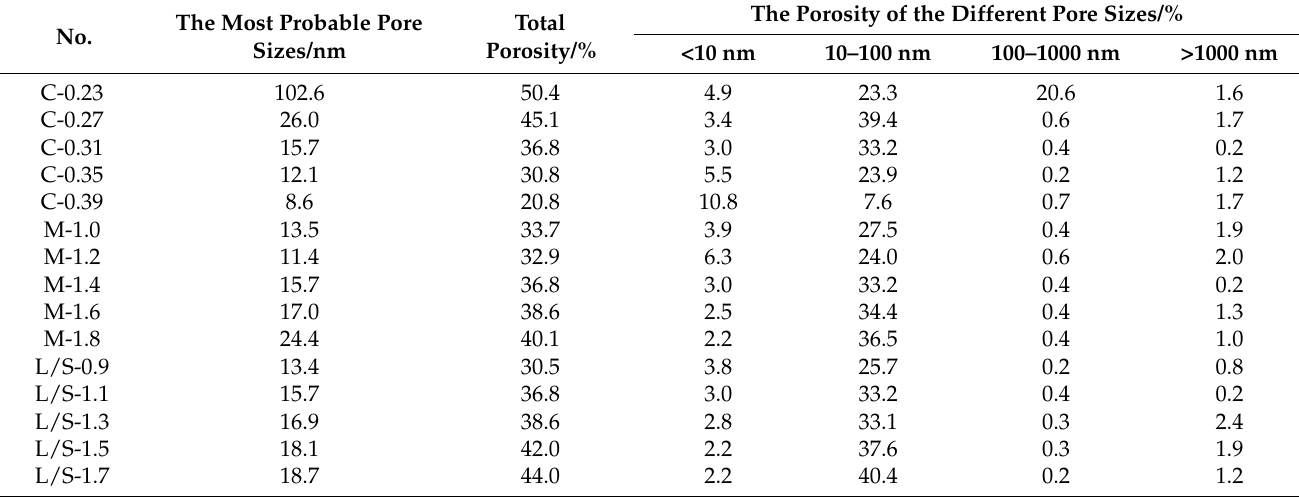
Table 4. The porosity of the different pore sizes and the most probable pore